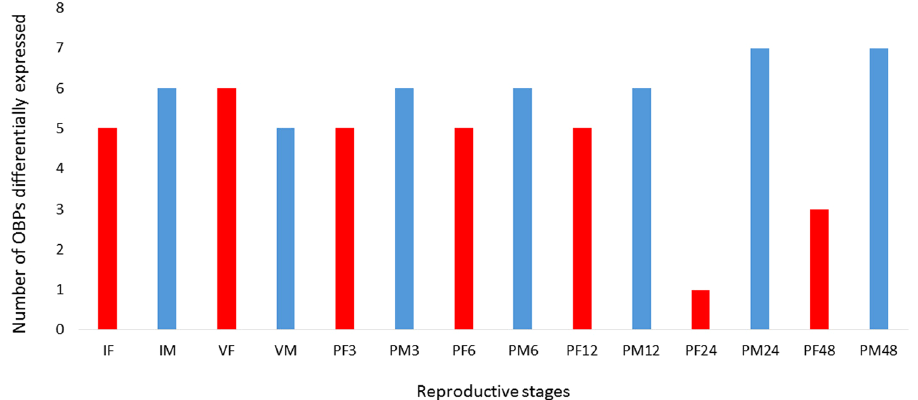
Figure 5. OBPs differentially expressed between A . fraterculus and A . obliqua females (red bars) and males (blue bars) for each profile analyzed. IF = immature female; VF = virgin female; PF3 = 3 h post-mating female; PF6 = 6 h post-mating female; PF12 = 12 h post-mating female; PF24 = 24 h post-mating female; PF48 = 48 h post-mating female. IM = immature male; VM = virgin male; PM3 = 3 h post-mating male; PM6 = 6 h post- mating male; PM12 = 12 h post-mating male; PM24 = 24 h post-mating male; PM48 = 48 h post-mating